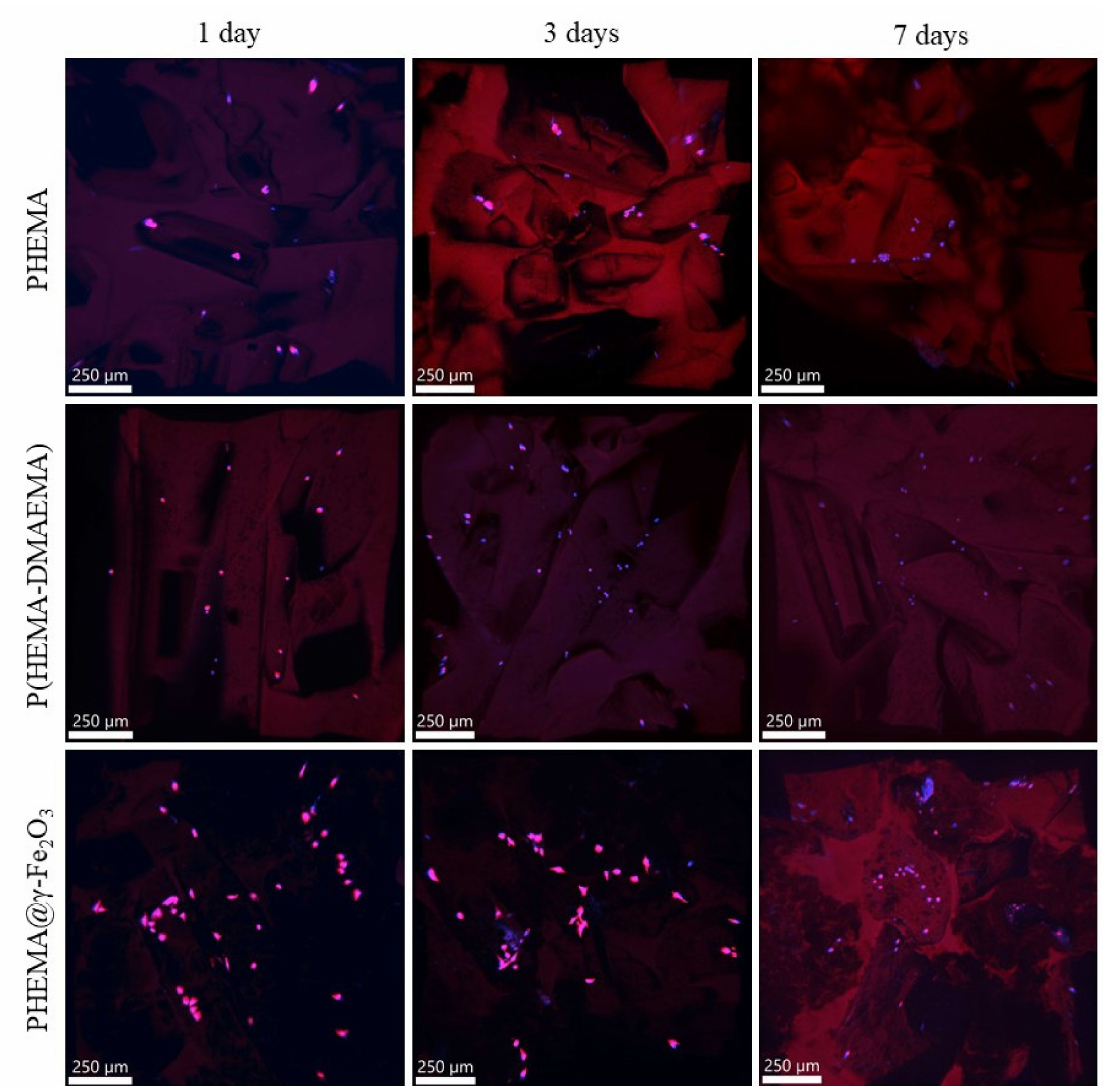
Figure 6. Confocal fluorescence micrographs of superporous PHEMA, P(HEMA-DMAEMA), and PHEMA@ γ -Fe 2 O 3 hydrogels after incubation with SAOS-2 cells for 1, 3, and 7